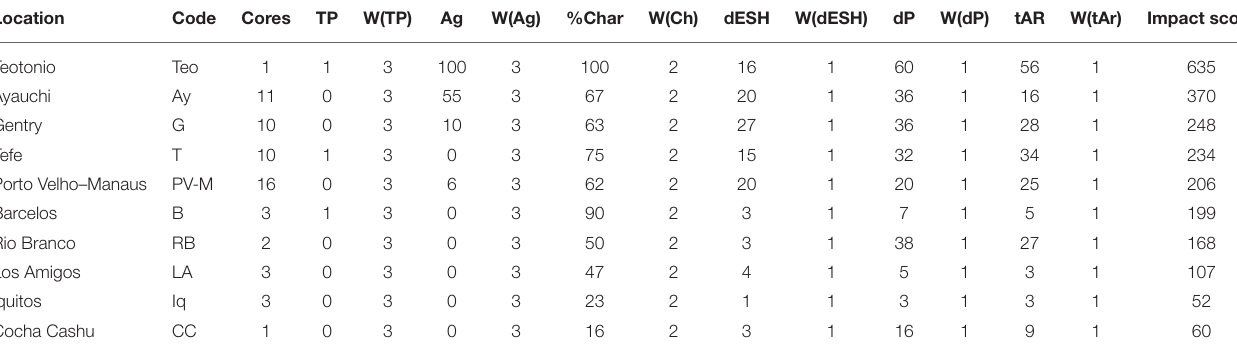
TABLE 4 | Human impact scores calculated from regions included in Figure 1. Location